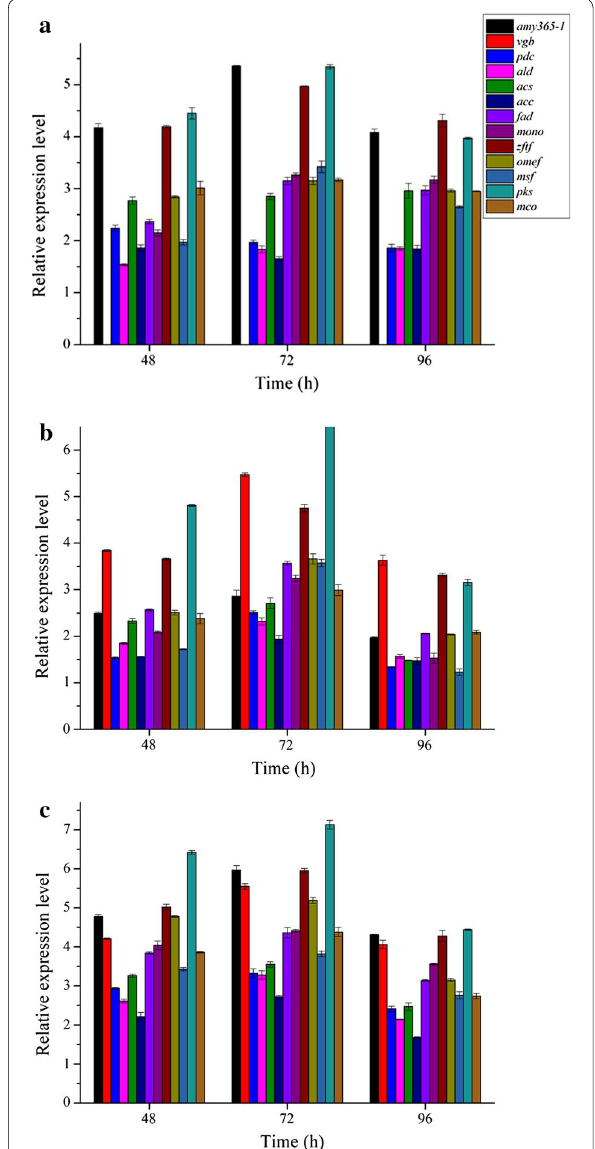
Fig. 3 Relative expression levels of amy365 - 1 , vgb , seven hypocrellin biosynthesis genes and four related genes in central carbon metabo- lism when cultured on corn flour. a Phygamy365-1, b Phygvgb and c PhygPgpdAamy365-1-vgb. The error bars represent standard devia- tion of triplicate measurements. Standard deviations were under 7 per cent of the